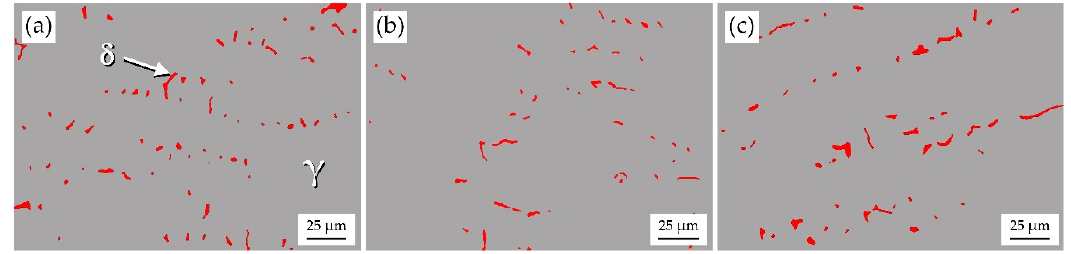
Figure 6. Processed OM images from the following specimens. ( a ) argon-1.1; ( b ) argon-1.2; and ( c ) argon-1.3.